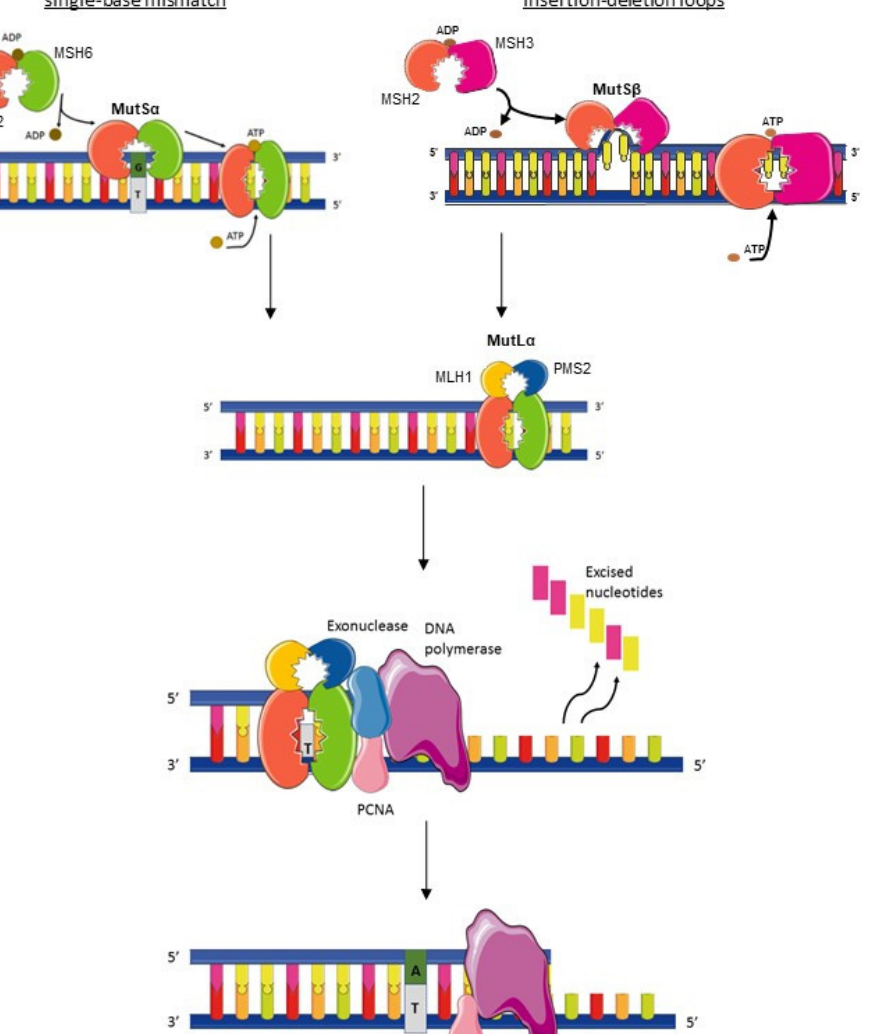
Figure 1. Mismatch repair mechanism. The MutS α (MSH2-MSH6 dimer) recognizes single-base-pair mismatch then surrounds the DNA like a clamp and the MutL α complex (MLH1-PMS2 dimer) is fixed on. The complex MutS β (MSH2- MSH3 dimer) recognizes insertion–deletion loops, then the MutL α complex is fixed on. Different enzymes (Exonuclease, PCNA, and DNA polymerase) then intervene to excise the mismatched base and to synthesize a new strand of DNA. PCNA: Proliferating cell nuclear antigen. ADP: Adenosine diphosphate. ATP: Adenosine